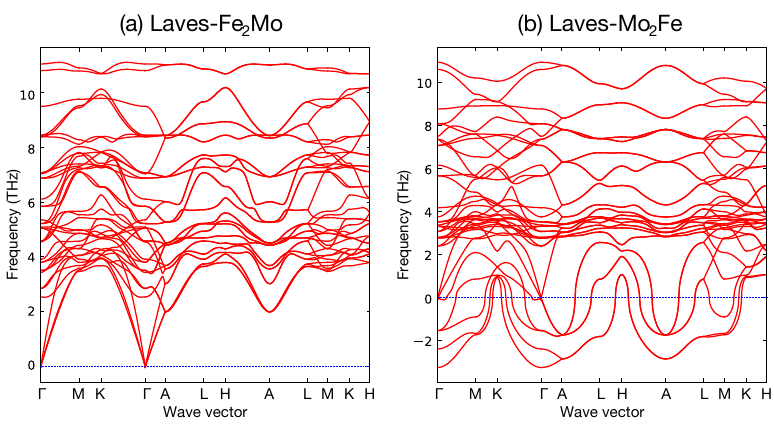
Figure 12. Phonon dispersions for Laves_C14 of ( a ) Fe 2 Mo and ( b ) FeMo 2